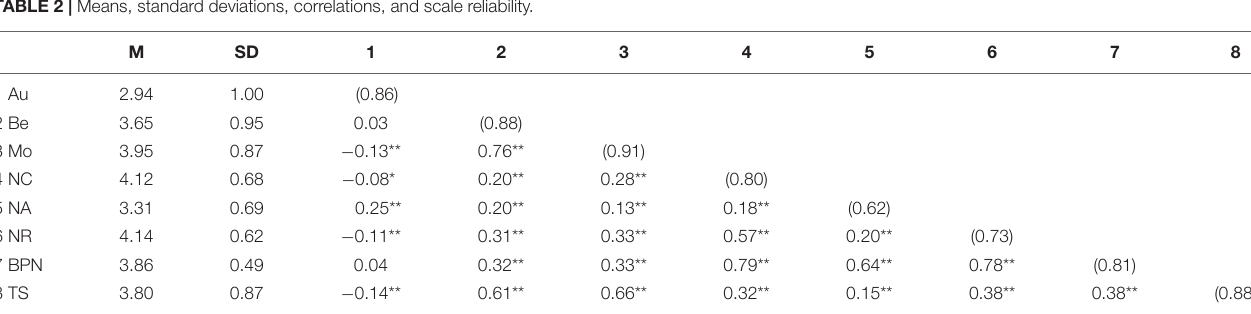
TABLE 2 | Means, standard deviations, correlations, and scale reliability.